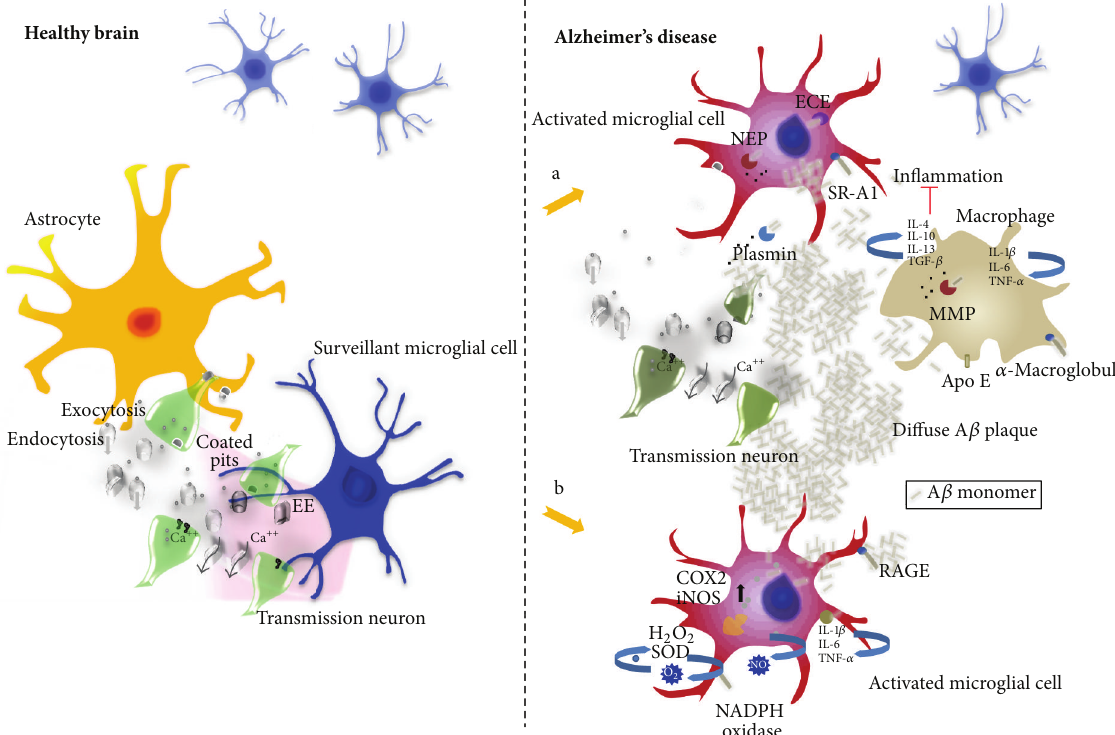
Figure 4: The role of microglial cells in Alzheimer’s disease. Increased accumulation of A 𝛽 peptides is thought to trigger a variety of pathological events, which subsequently compromise neuronal function. For example, A 𝛽 molecules are known to interact with neurotransmitter receptors, disrupt synaptic and mitochondrial function, and promote neuronal proapoptotic signalling. Injured neurons release a variety of factors that together with A 𝛽 accumulation trigger microglial activation. (a) Extracellular A 𝛽 is taken up and degraded by microglia via receptors such as 𝛽 -integrins, various enzymes including MMPs, and other uptake-mediating molecules, for example, ECE and NEP. Additionally, macrophages can degrade A 𝛽 molecules and, together with microglia, help restrict amyloid plaque formation in the brain. These activities might represent an important recovery-promoting mechanism. (b) In response to the deposition of A 𝛽 and the release of chemoattractants from injured neurons, activated microglia can release a range of proinflammatory mediators such as cytokines (IL-1 𝛽 , IL-6, and TNF- 𝛼 ) and induce generation of reactive oxygen species. Although this initial response might be an attempt to protect the brain, these proinflammatory activities are believed to be a major detrimental factor, worsening the disease